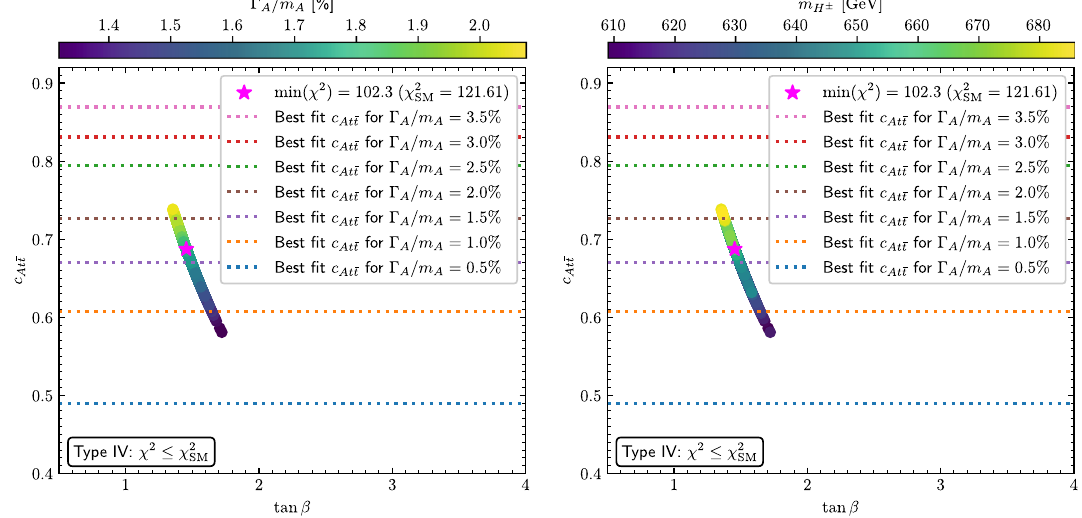
Fig. 19 c At ¯ t in dependence of tan β . The colors of the points indicate the values of (cid:8) A / m A in % (left) and the values of m H ± (right). The dashed horizontal lines indicate the best-fit values of c At ¯ t for different width hypotheses in the experimental analysis